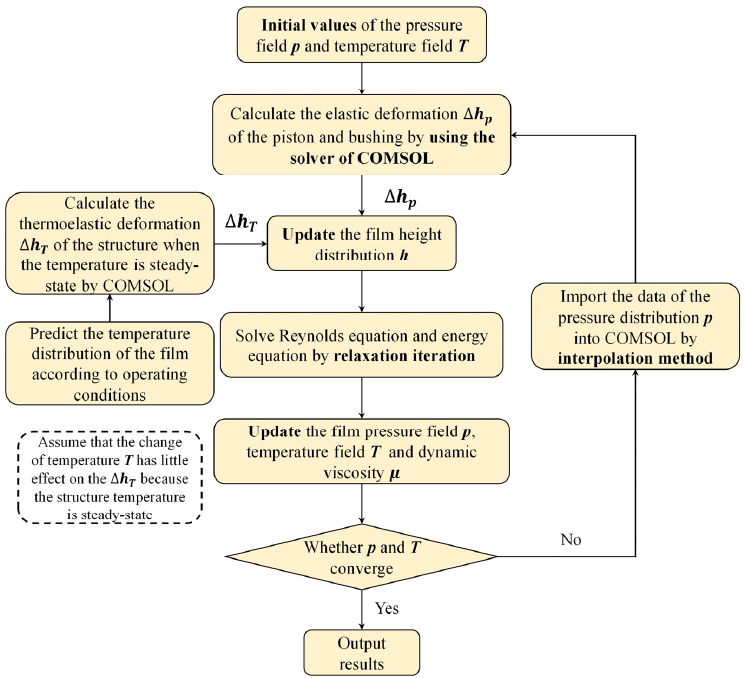
Figure 7. Fluid–structure–thermal interaction.